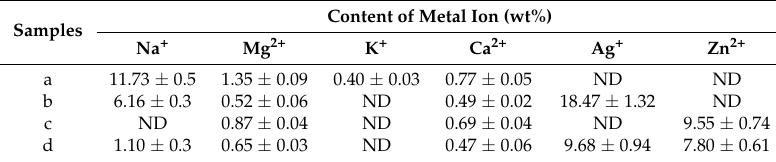
Table 1. The content of metal ions in ion-exchanged permutite.